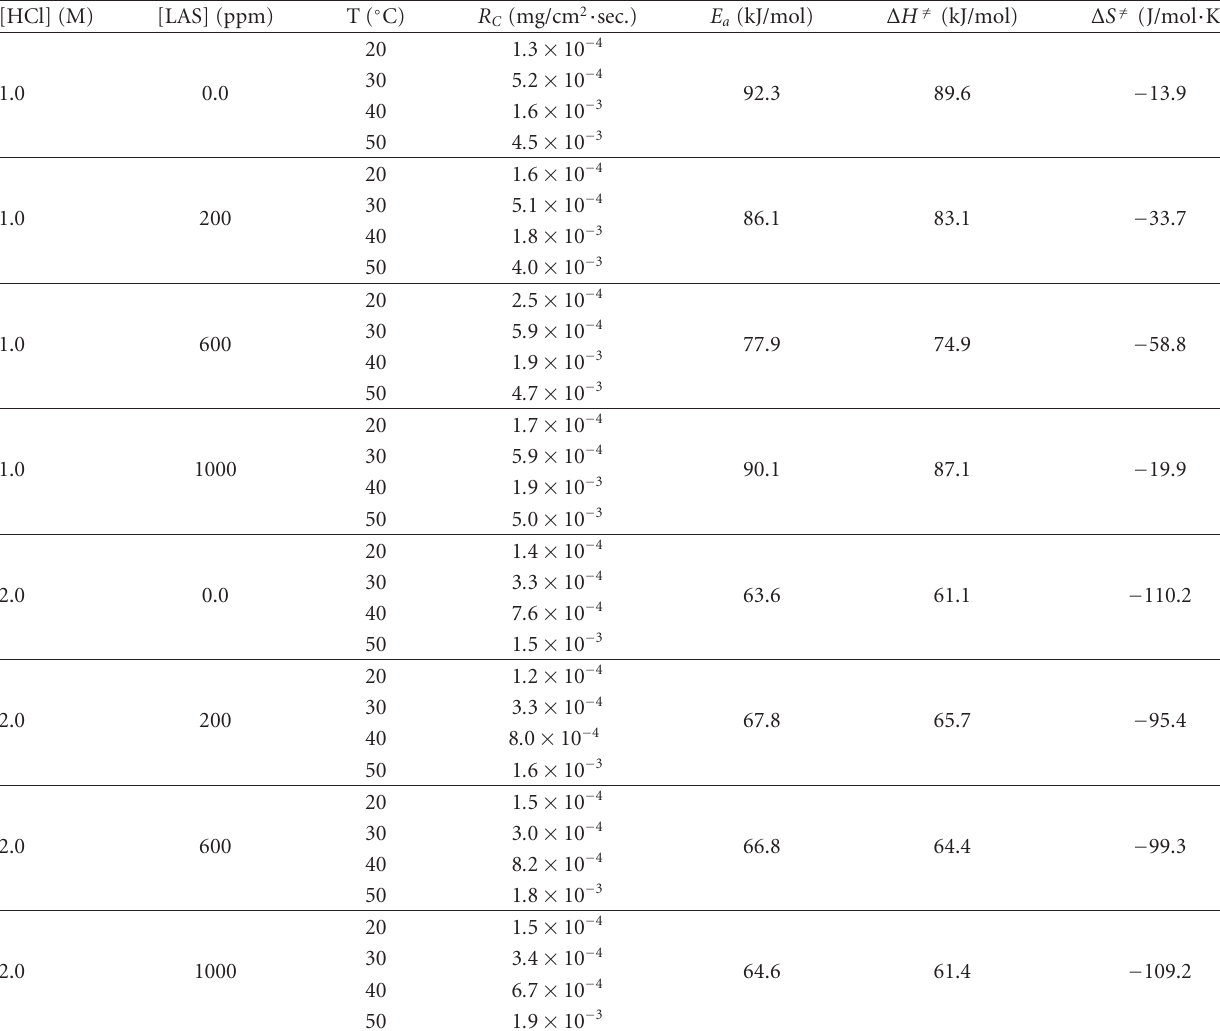
Table 1: Kinetic and thermodynamic parameters of corrosion process in HCl solution in the absence of magnetic field. [HCl]